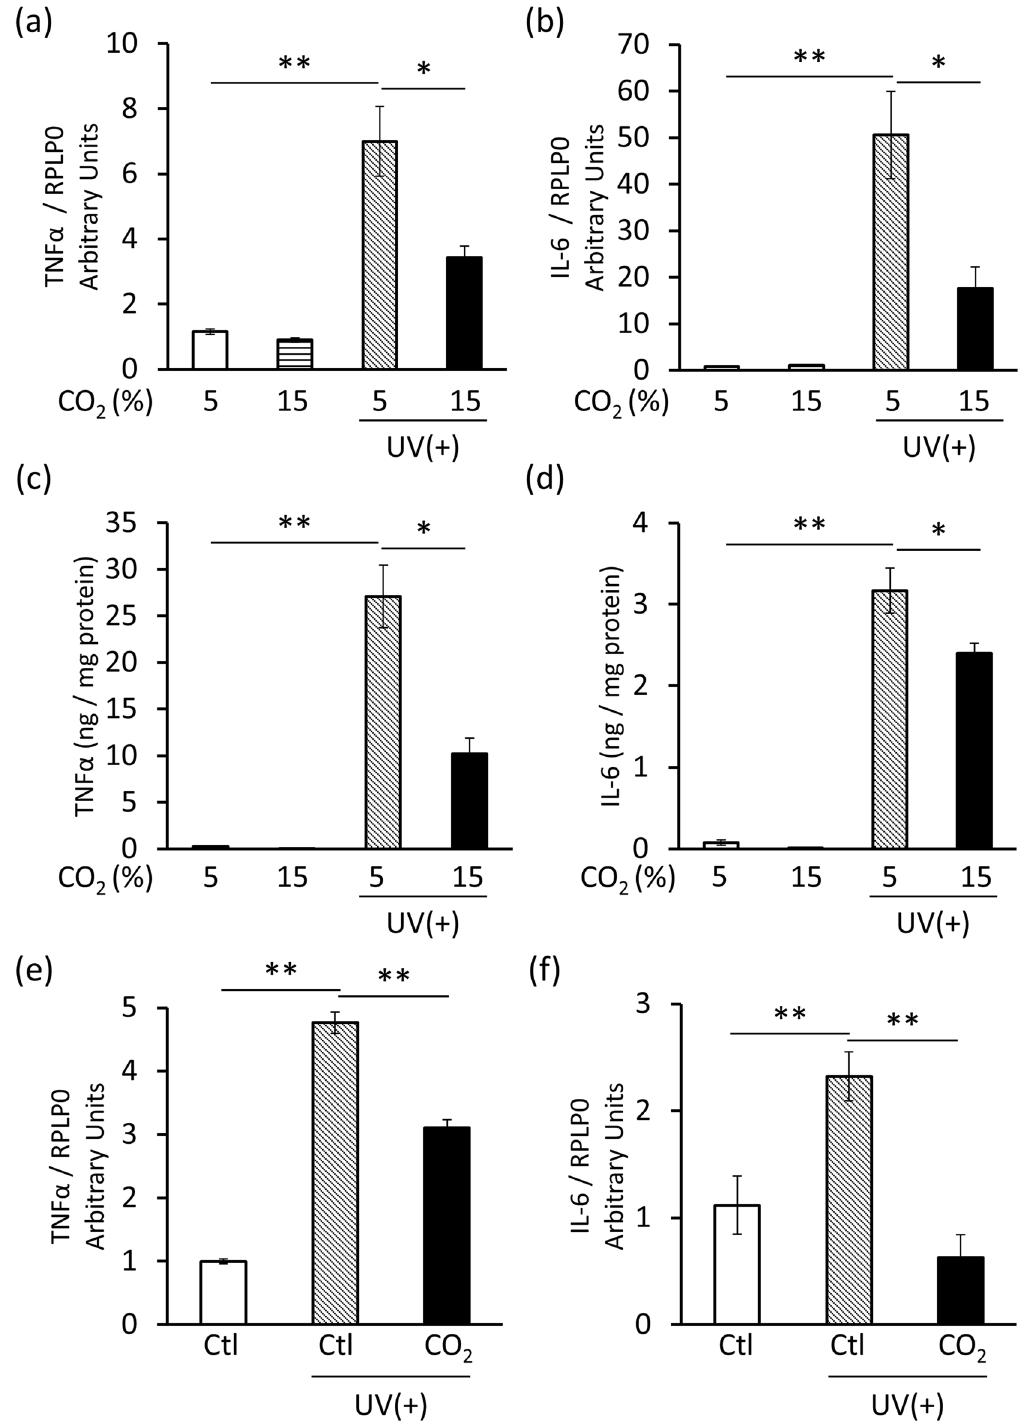
Figure 1. CO 2 inhibits UVB-induced cytokine expression in HEKn and the 3D epidermis. ( a , b ) HEKn were incubated in 5 or 15% CO 2 for 24 h and then irradiated with 20 mJ/cm 2 of UVB. Total RNA was isolated 8 h later and qRT-PCR was performed to detect TNFα and IL-6 mRNA expression ( n = 3, * P < 0.05, ** P < 0.01 vs. 5% CO 2 UV(+), Dunnett’s test). ( c , d ) The culture supernatant was collected 24 h after UVB irradiation and ELISA was performed to measure TNFα and IL-6 concentration ( n = 3, * P < 0.05, ** P < 0.01 vs. 5% CO 2 UV(+), Dunnett’s test). ( e , f ) CO 2 -free (Ctl) and high-CO 2 concentration (CO 2 ) formulations were applied to the surface of the 3D epidermis for 12 h and then exposed to UVB. Total RNA was isolated 8 h later, and qRT-PCR was performed to detect TNFα and IL-6 mRNA expression ( n = 3, ** P < 0.01 vs. Ctl UV(+), Dunnett’s